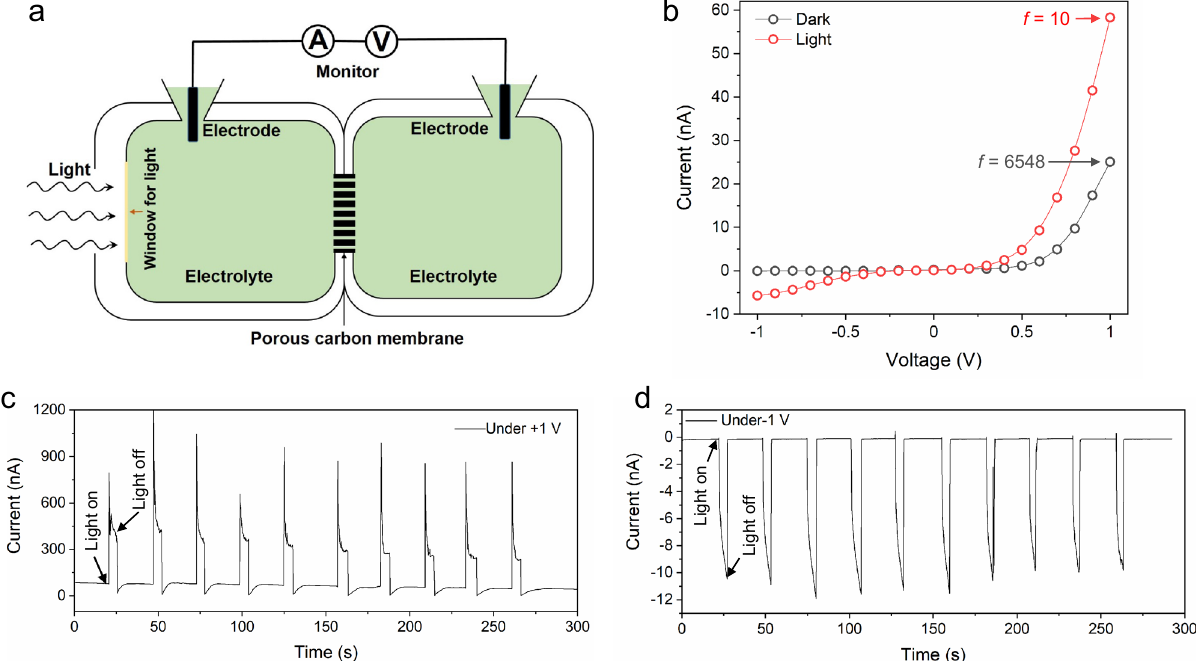
Fig. 5 Light-gated properties. a Schematic of light-gated ion transport of CMHPA. b Typical current – voltage curves and calculated recti fi cation ratio before and after light (320 mW/cm 2 ) irradiation at 0.01 M KCl. c Measured cyclic constant current under + 1 V with alternating illumination. d Measured cyclic constant current under − 1 V with alternating